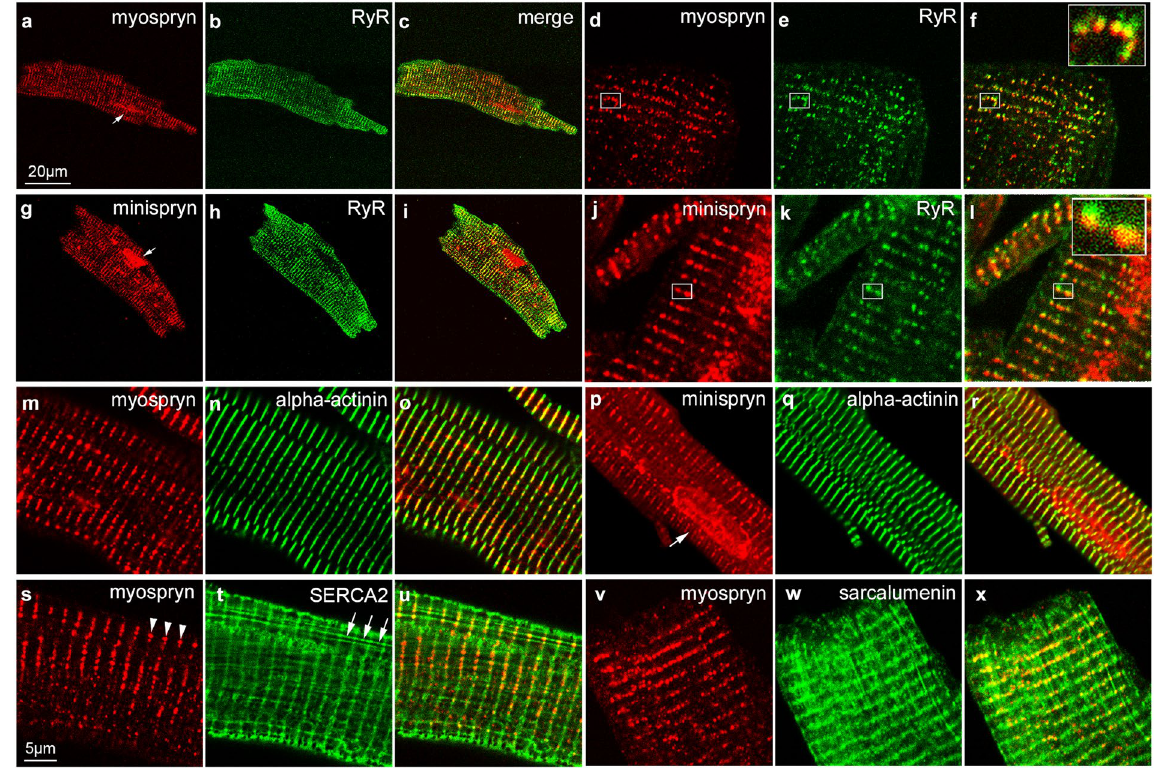
Figure 4. Immunolocalization of myospryn and minispryn in isolated cardiomyocytes. Enzymatically isolated guinea pig ventricular cardiomyocytes were fixed and processed for confocal immunofluorescence microscopy using the indicated antibodies. ( a – c ) At low magnification myospryn (a) immunoreactivity is visible in discontinuous striations that run perpendicular to the long axis of the cardiomyocyte partially overlapping the nucleus (arrow in a). ( d – f ) Higher magnification images show that myospryn immunoreactivity is present in distinct punctae that co-localise with ryanodine receptors (e) in the SR (f and inset). ( g – i ) Anti-minispryn (g) immunoreactivity also appears in discontinuous striations running the length of the cardiomyocyte and is also present in the nucleus (arrow in g). ( j – l ) In common with myospryn, higher magnification images show that minispryn partially co-localises with ryanodine receptors (k) in the SR (l and inset). ( m–o ) Myospryn immunoreactivity overlaps the Z-line labelled with an anti-alpha-actinin antibody (m, n, o). ( p – r ) Similarly, minispryn immunoreactivity also partially overlaps alpha-actinin at the Z-line (p, q, r). ( s – x ) Cardiomyocytes labelled with either anti-SERCA2 (s, t, u) or anti-sarcalumenin (v, w, x) antibodies and myospryn antibodies demonstrate that myospryn immunoreactivity (arrowheads in s) appears to be restricted to the j-SR rather than the l-SR (arrows in